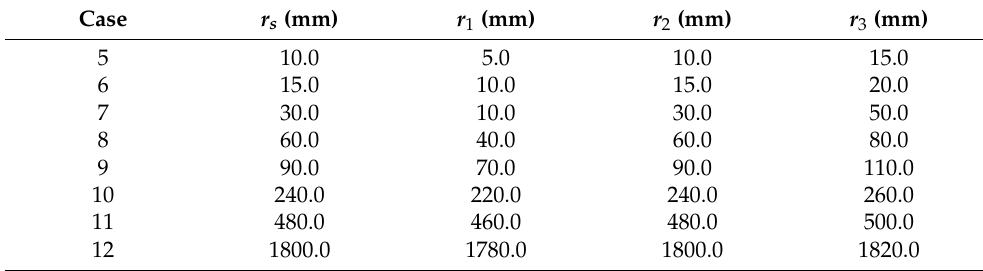
Table 3. Extended test configurations.